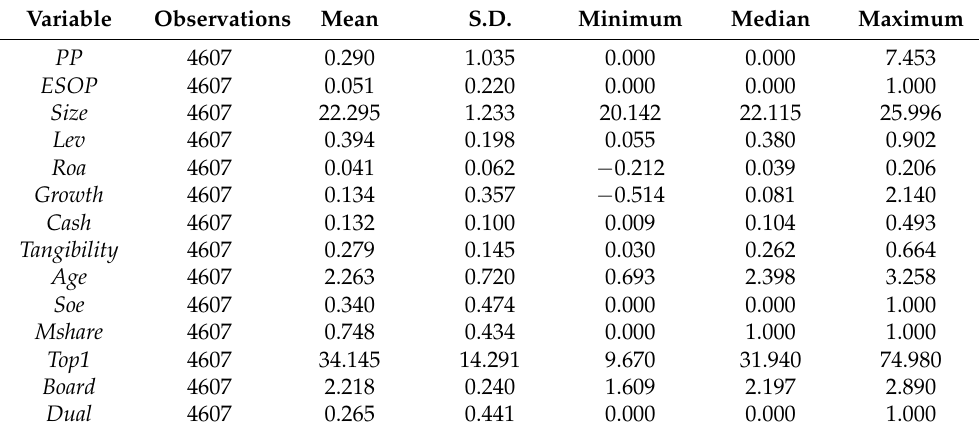
Table 2. Descriptive statistics.